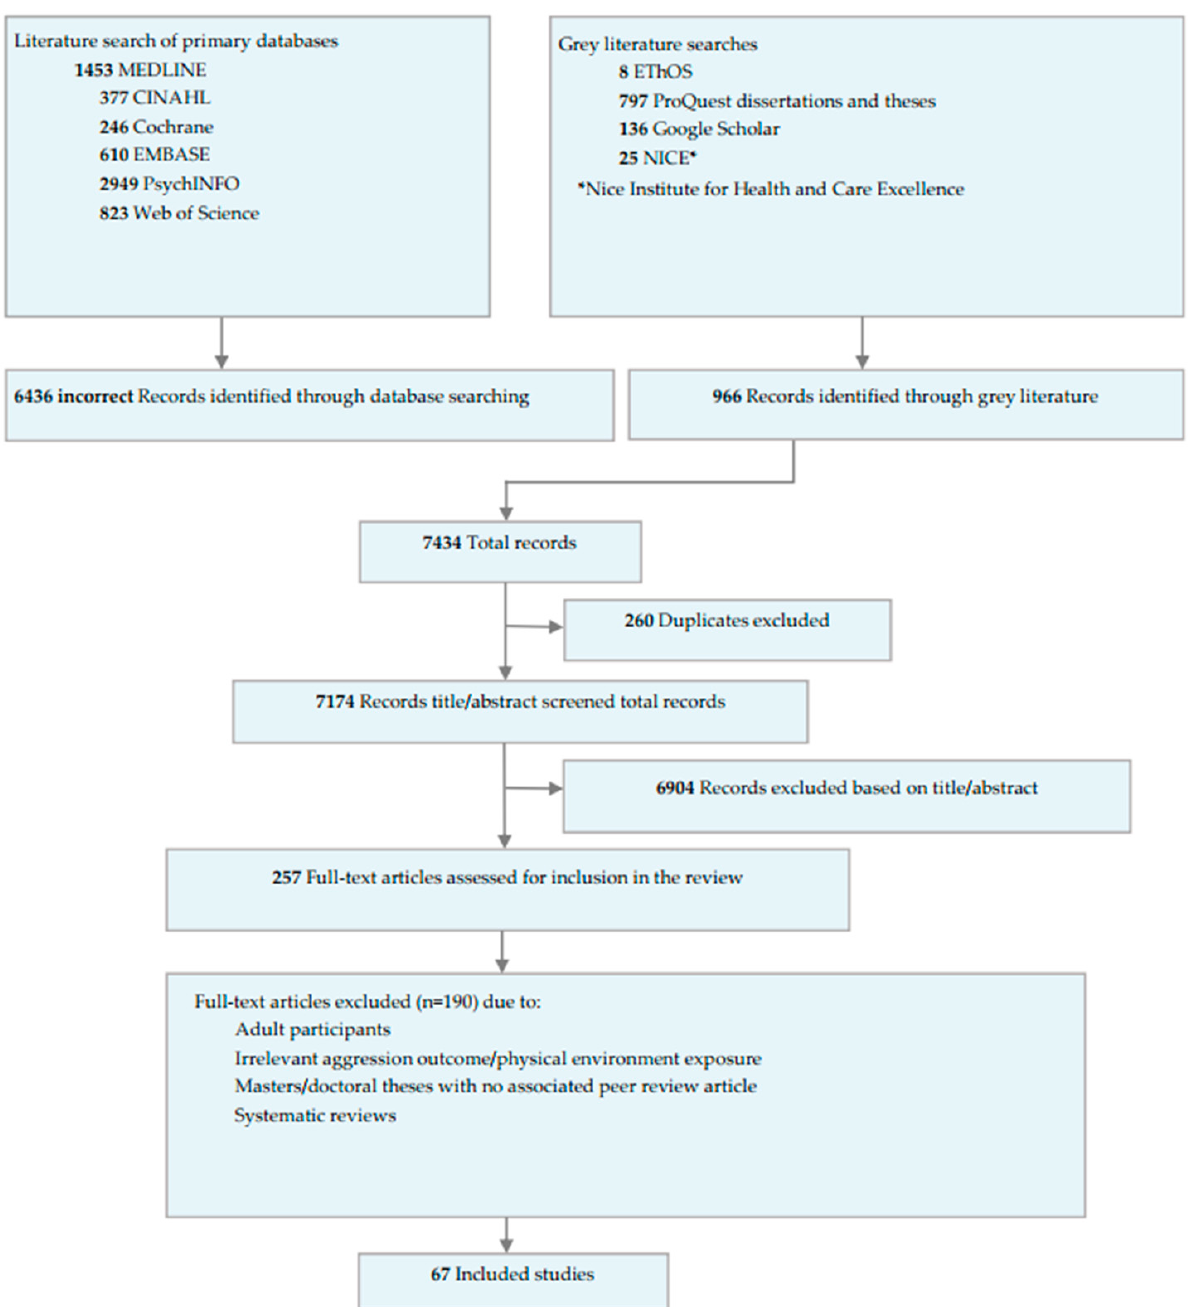
Figure 1. PRISMA flow diagram of the included studies.